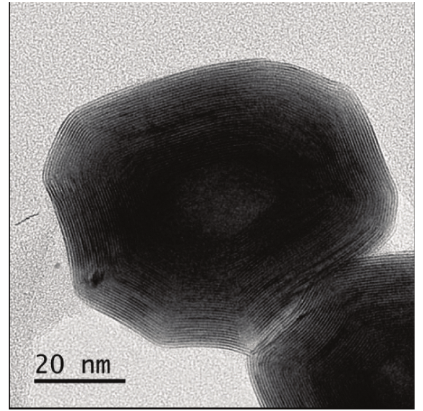
particle before 2